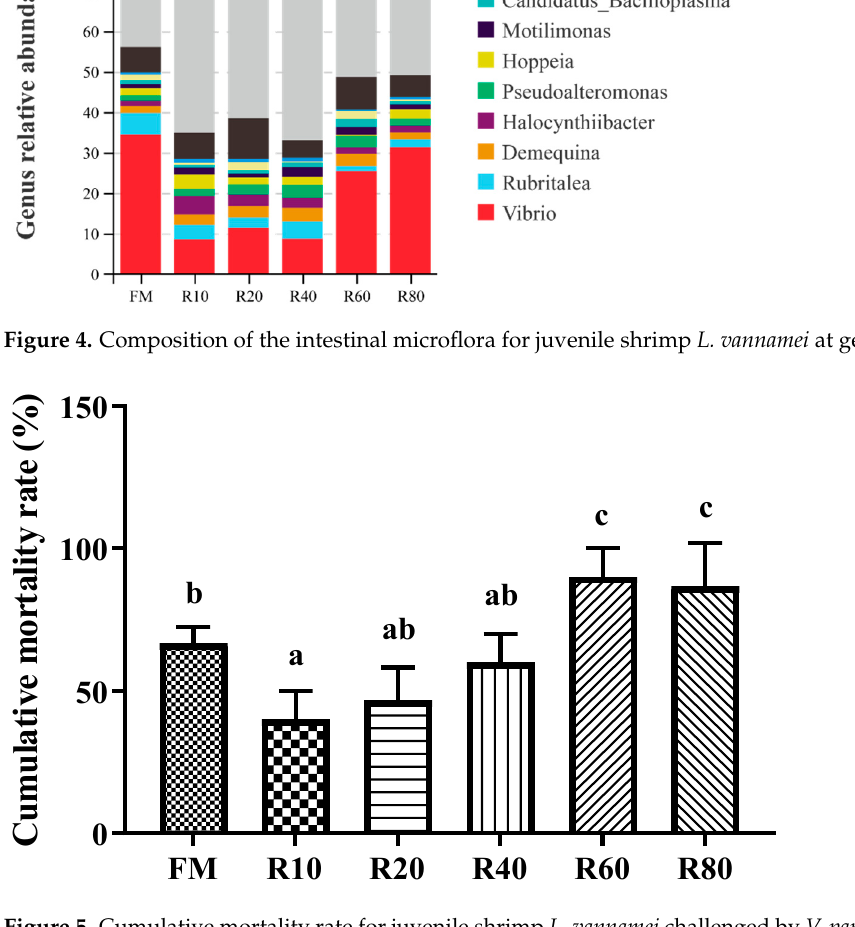
Figure 4. Composition of the intestinal microflora for juvenile shrimp L. vannamei at genus level.